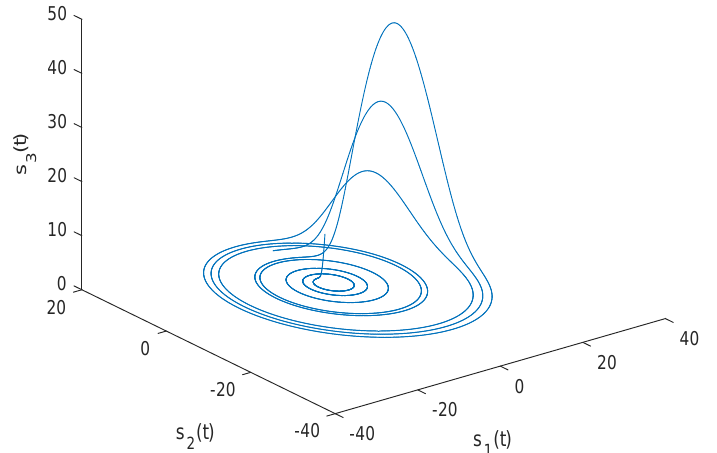
Figure 4. The chaotic behavior of System